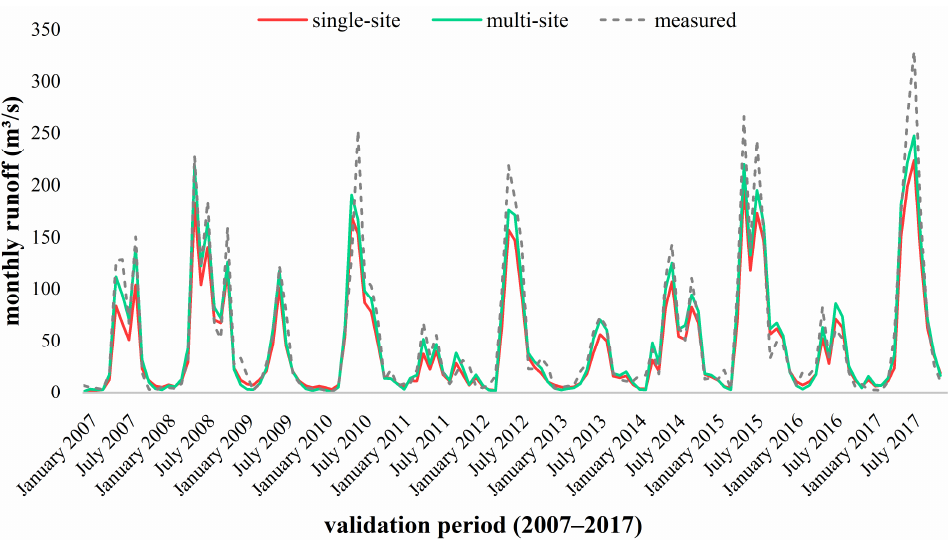
Figure 7. Monthly simulated runoff during the validation period.